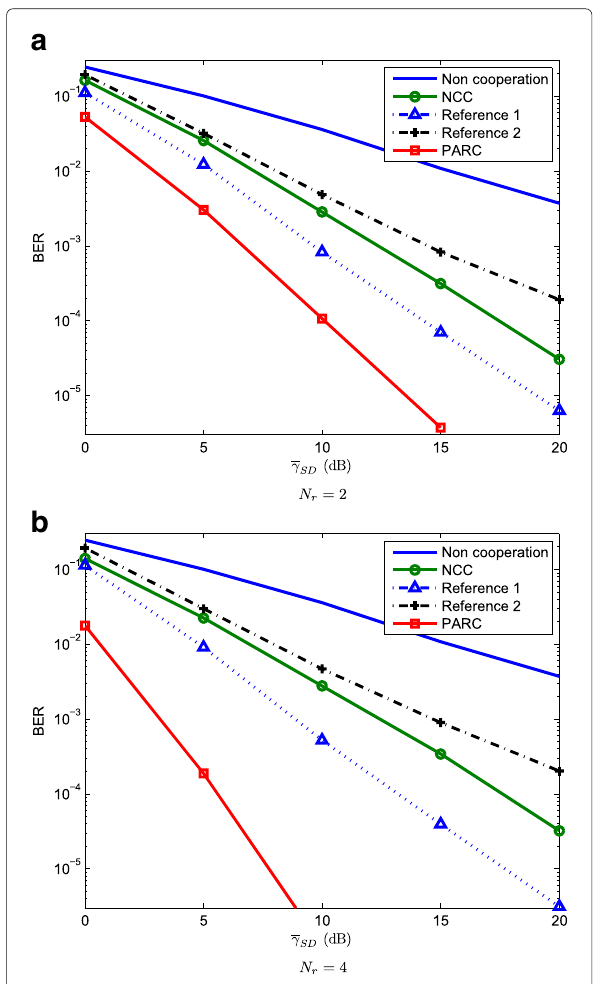
Fig. 4 Performance comparison between PARC and NCC when the CC [133 165 171] with the minimum distance f = 15 and the rate 1/3 is used